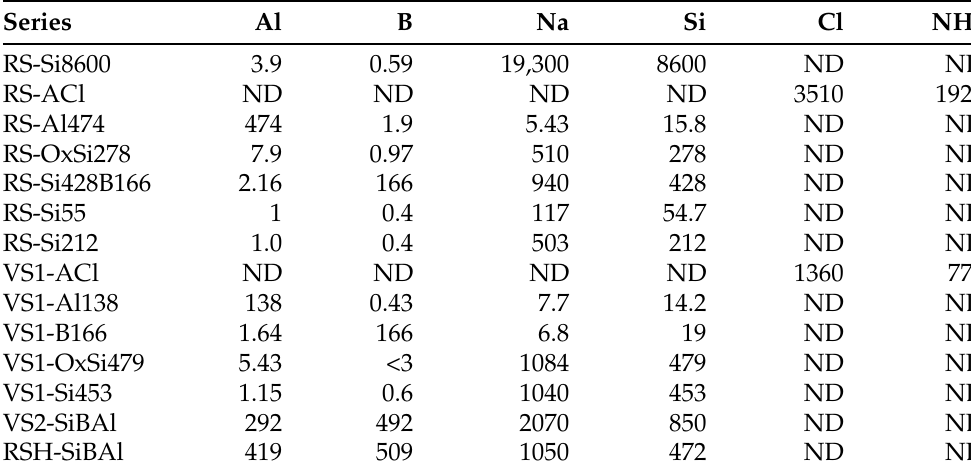
Table 2. Measured concentrations in µgL − 1 of spiked feed-water samples.